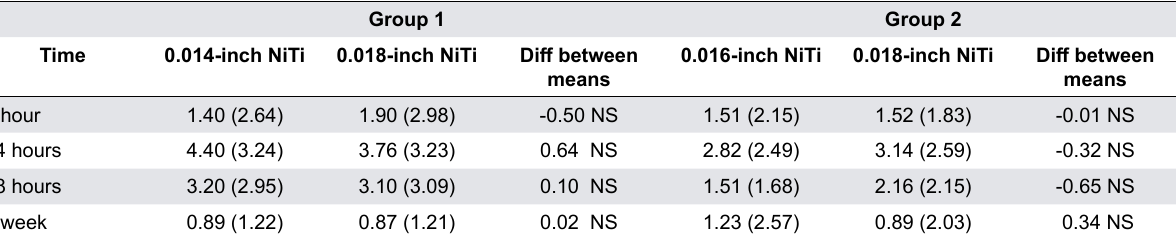
Table 6- Means and SD for pain scores for each group and the difference between the two archwire sizes within the same group